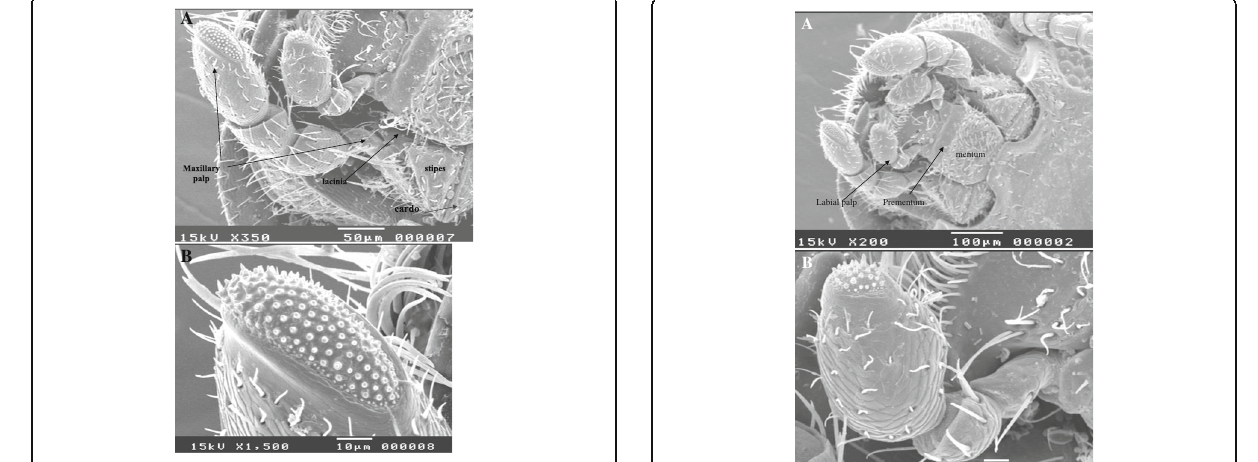
Fig. 4 a Higher magnification of the mouth parts showing the maxilla which its base consists of two segments, the cardo, and the stipes. The lacinia is short with bidentate apical. The maxillary palp consists of four segments. b Higher magnification of the distal palp segment which is elongated and terminate in a field of sensory receptors